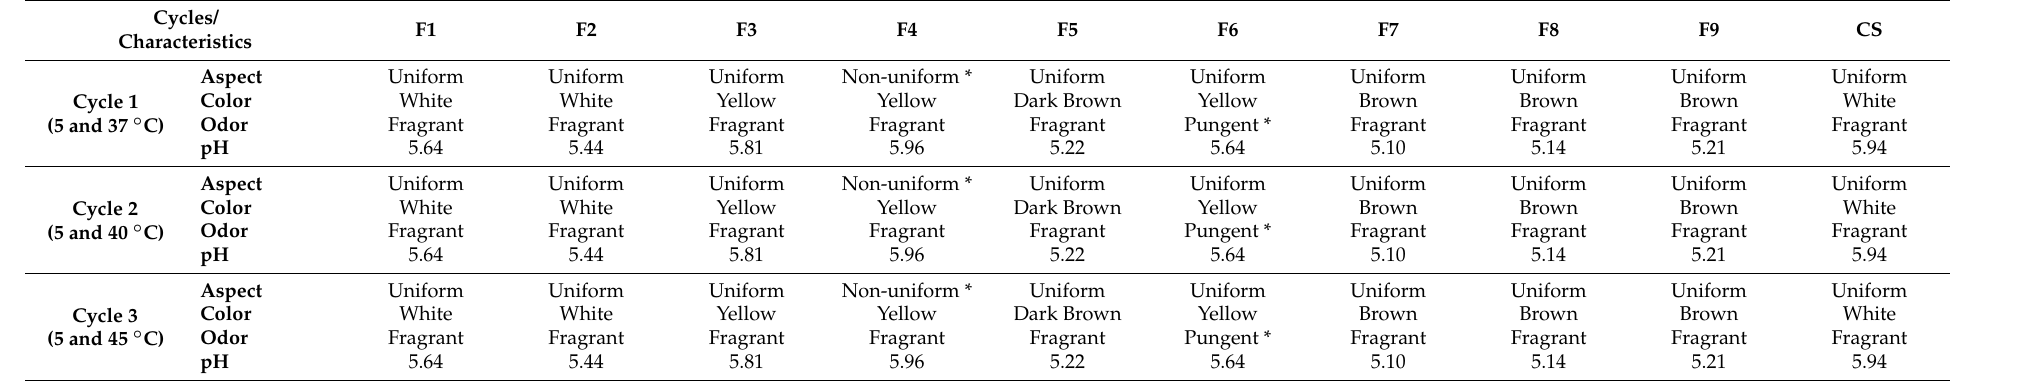
Table 10. Organoleptic characteristics of the formulations submitted to alternating heating and cooling cycles. The codes of the formulations are given in Table